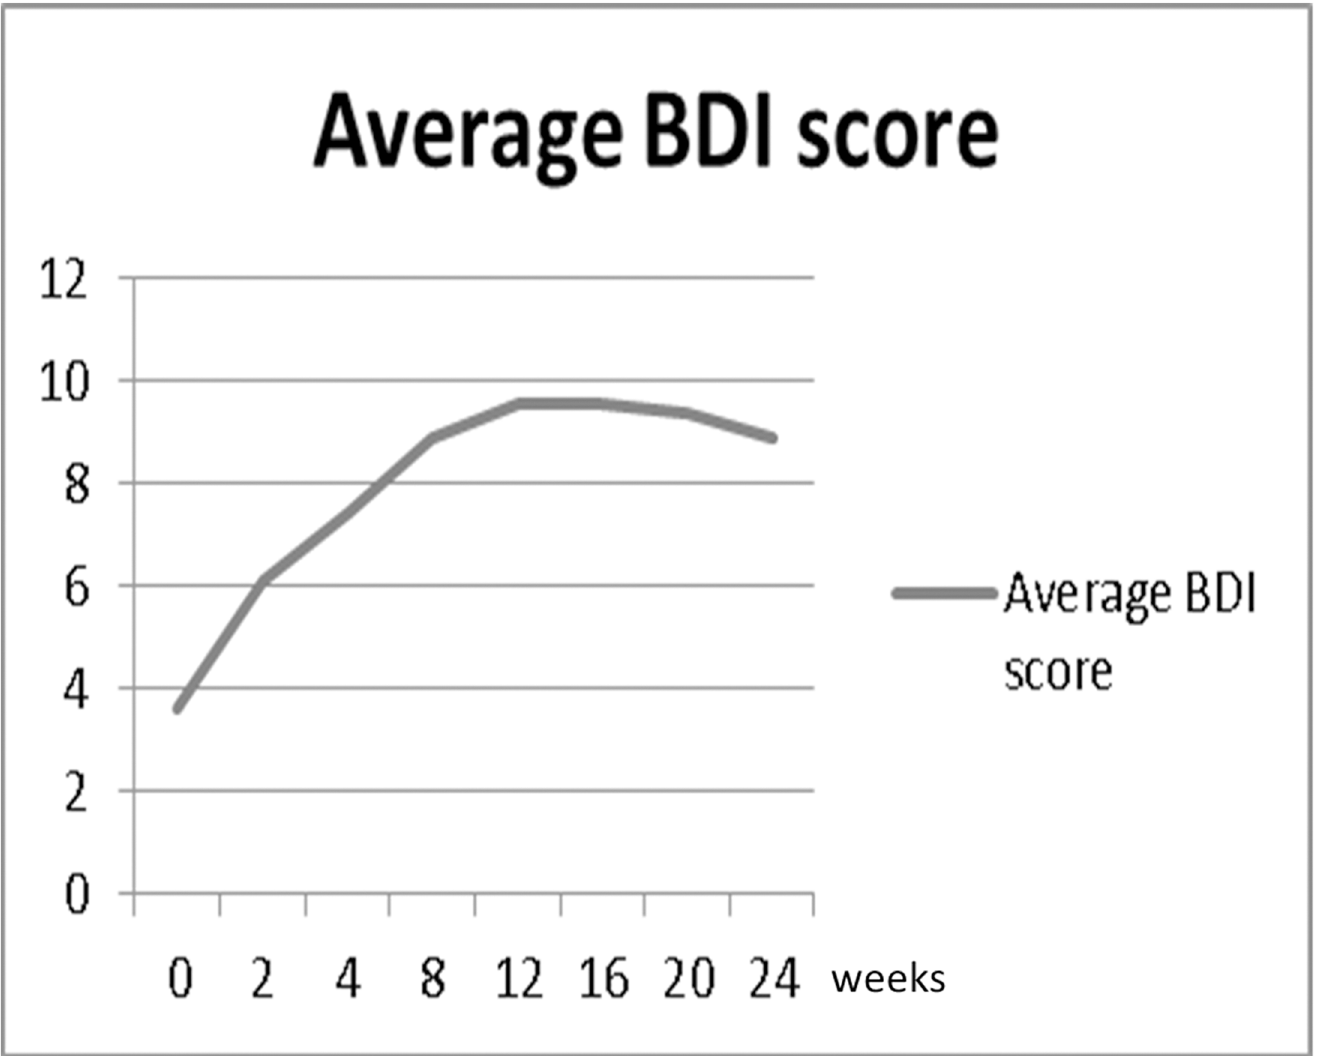
Fig 3. Time course of the total Beck Depression Inventory (BDI) scores in hepatitis C patients before (week 0) and during anti-viral therapy. The higher values represented greater